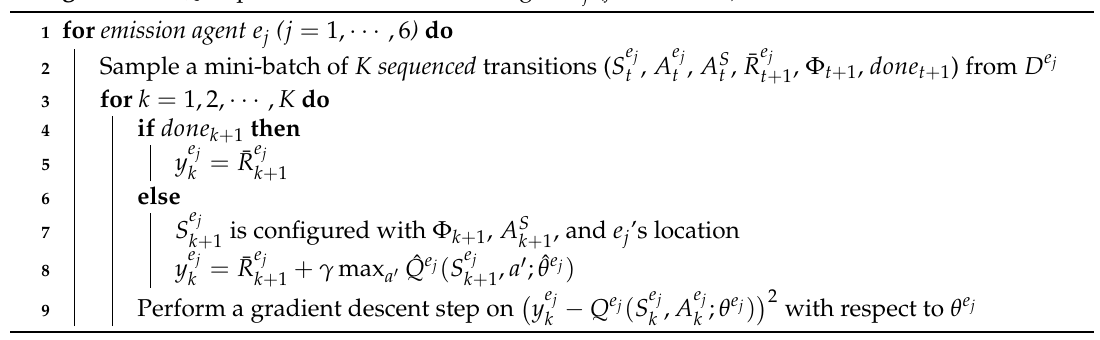
Algorithm 3: Q e j optimization for emission agent e j ( j = 1,